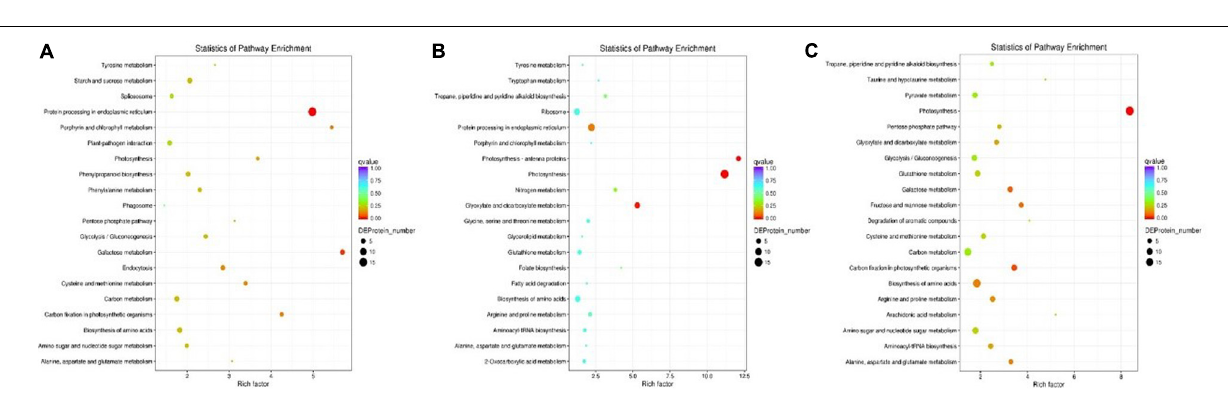
GST (VIT_07s0005g04890) activity may contribute to